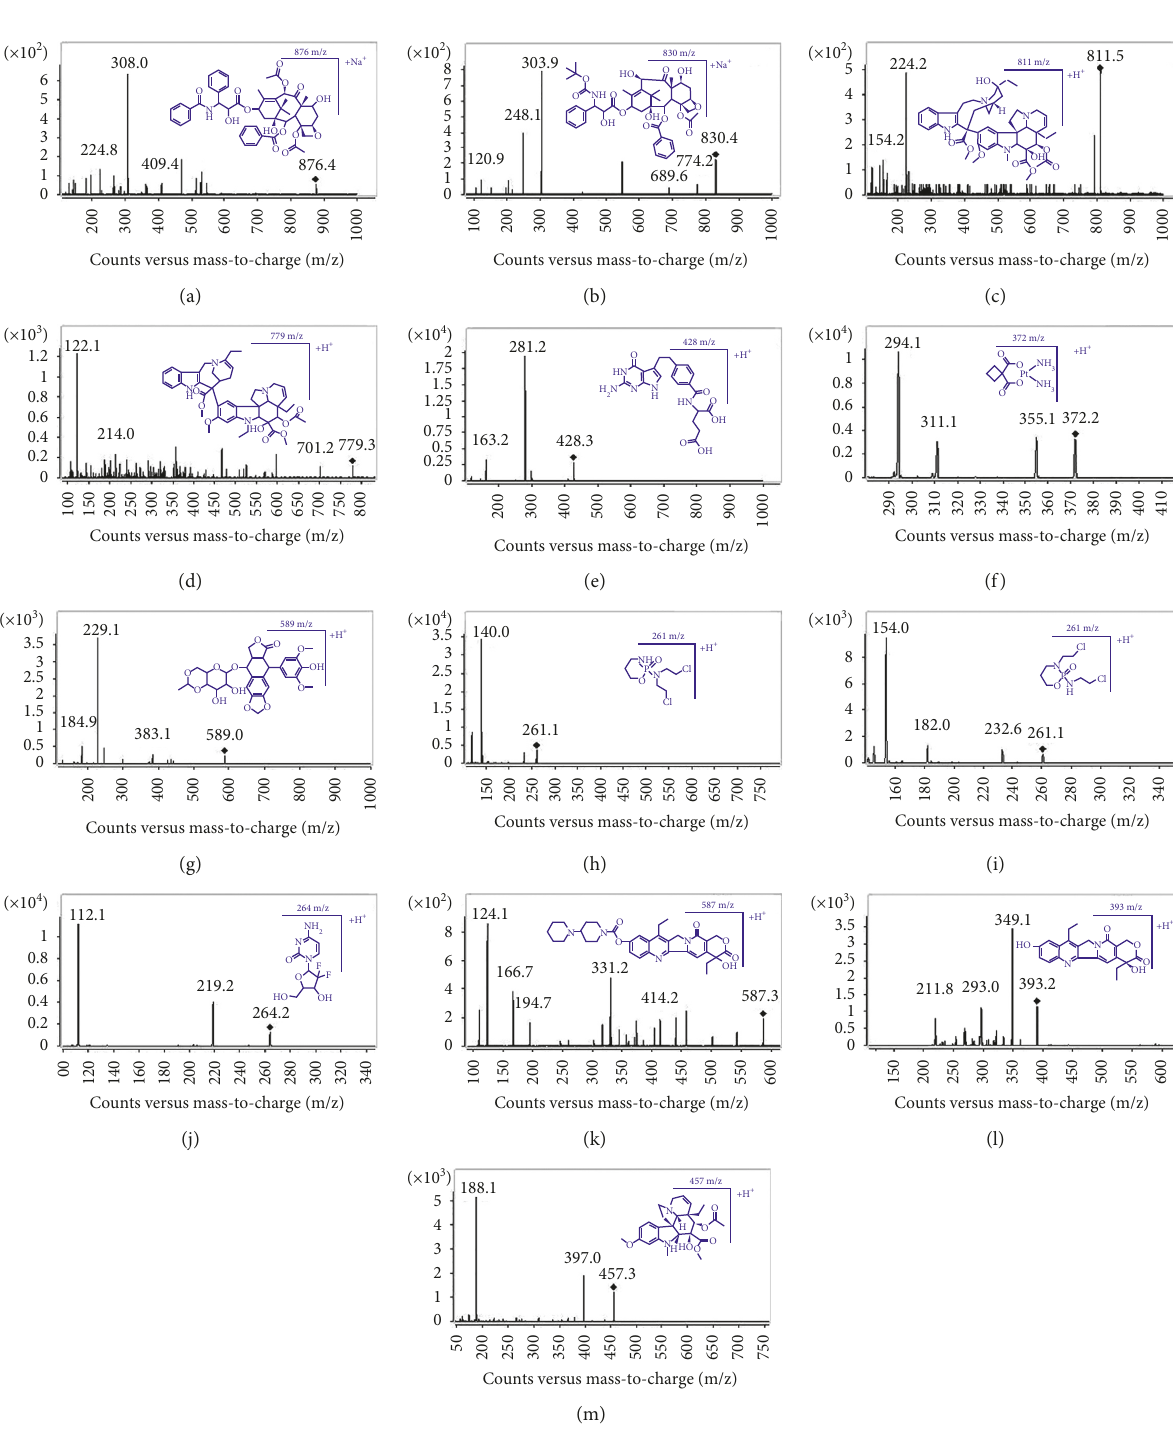
Figure 1: Chemical structures and multiple reaction monitoring ions of paclitaxel (a), docetaxel (b), vinblastine (c), vinorelbine (d), pemetrexed (e), carboplatin (f), etoposide (g), cyclophosphamide (h), ifosfamide (i), gemcitabine (j), irinotecan (k), SN-38 (l), and vindoline ((m),